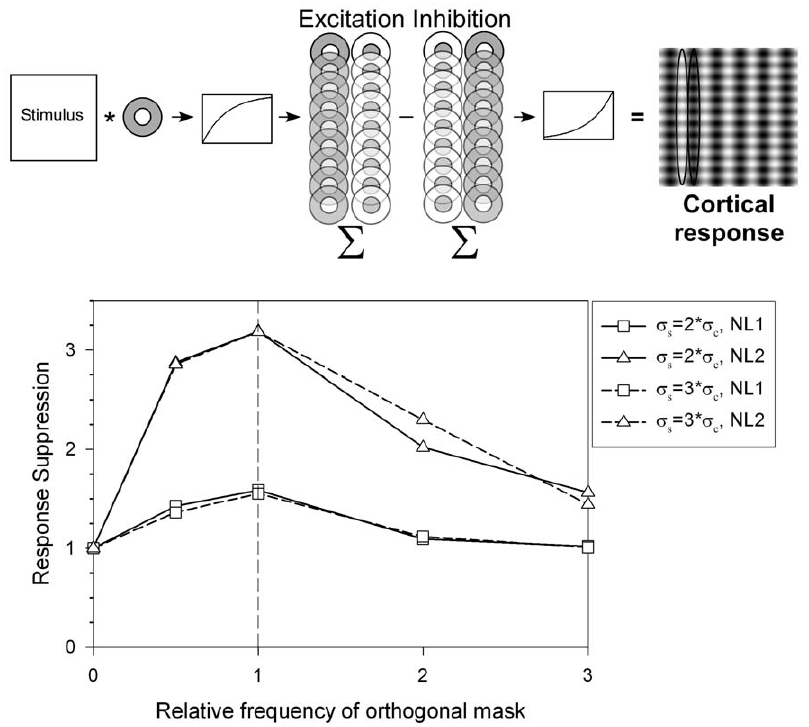
Figure 3. Response suppression in a feed-forward model of cross-orientation suppression as a function of mask frequency. Top: Responses of On- and Off-center LGN cells were convolved with the stimulus, passed through a compressive non-linearity, summed in excitatory and inhibitory push-pull form, and passed through an expansive cortical spike threshold non-linearity. Bottom: Response suppression of the model (response to the test grating alone divided by the response to the test plus the orthogonal mask) as a function of the relative frequency of the orthogonal mask. Response suppression was frequency selective for two different center-surround variance ratios ( s s =2 s c plotted in solid lines and s s = 3 s c plotted in dashed lines) and two different compressive nonlinearities (k=e in Equation 2 for NL1 plotted in squares, and k=max(abs(L)) in Equation 2 for NL2 plotted in triangles).